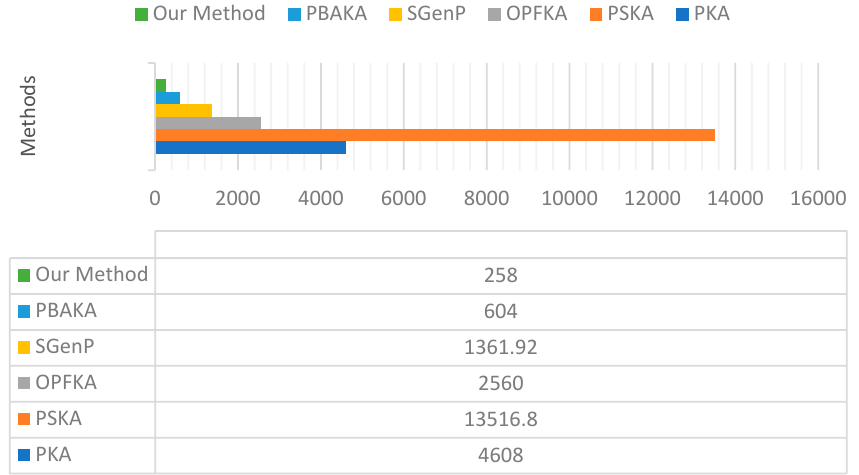
Figure 9. Total communication overhead in bytes for the proposed method and other methods. Table 7. The energy consumption for first/later connections.